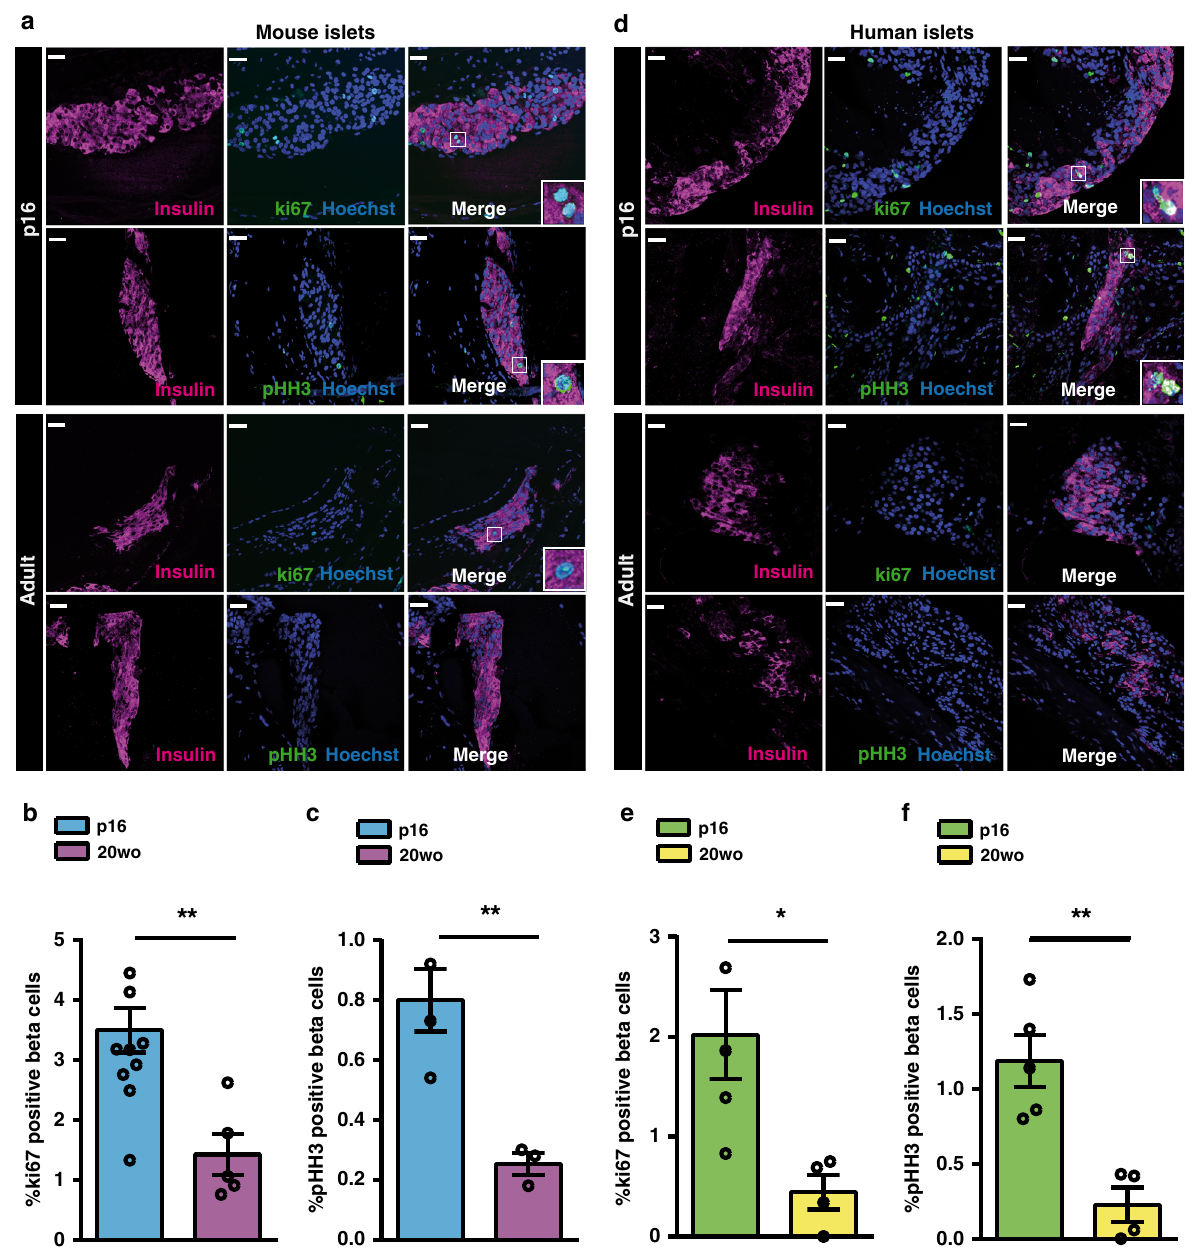
Fig. 1 Adult beta cells exhibit enhanced replication when transplanted into pre-weaning mice. a – c Beta cell replication of 20wo mouse islet grafts 12- days after implantation into the anterior chamber of the eye of p16 or 20wo C57BL6/J recipients. a Representative images of islet grafts co-immunostained for insulin (purple) /ki67 (green) or insulin (purple)/pHH3 (green). Nuclei are marked with Hoechst in blue. b Quanti fi cation of the percentage of beta (insulin + ) cells that are ki67 + in islet grafts transplanted into p16 ( n = 11, blue) and 20wo ( n = 5, purple) mice. c Quanti fi cation of the percentage of beta (insulin + ) cells that are pHH3 + in islet grafts transplanted into p16 ( n = 4, blue) and 20wo ( n = 3, purple) mice. d – f Beta cell replication of adult human islet grafts 12-days after implantation into the anterior chamber of the eye of p16 or 20wo NSG-SCID mouse recipients (islets from two donors). d Representative images of islet grafts co-immunostained for insulin (purple)/ki67 (green) or insulin (purple)/pHH3 (green). Nuclei are marked with Hoechst in blue. e , f Quanti fi cation of the percentage of beta (insulin + ) cells that are ki67 + ( e ) or pHH3 + ( f ) in human islet grafts transplanted into p16 ( n = 5, green) or 20wo ( n = 4, yellow) mice. Data shown represent mean ± SEM for the indicated n. * p < 0.05; ** p < 0.01, using two-tailed Student ’ s t test. Scale bars are 25 μ